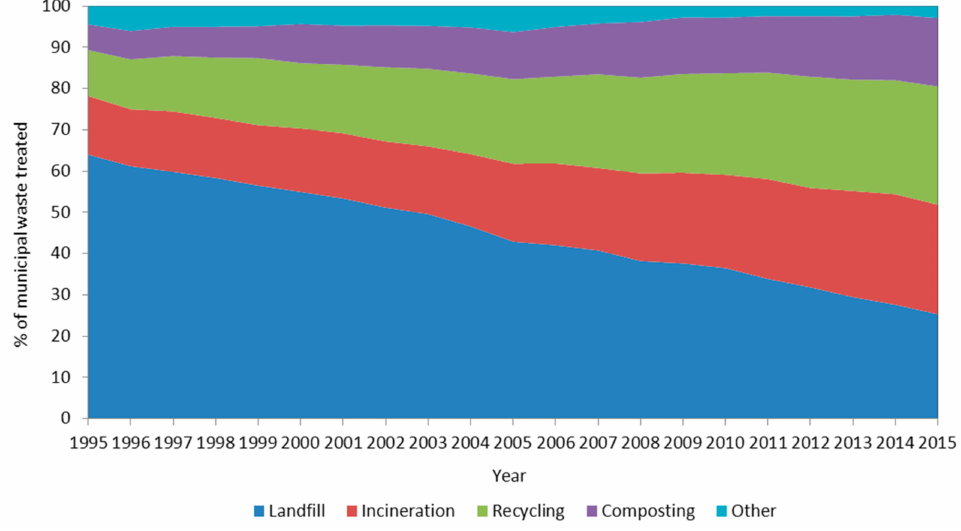
Figure 1. Municipal waste management by type of treatment, EU-27 (%), 1995–2015 (Source: